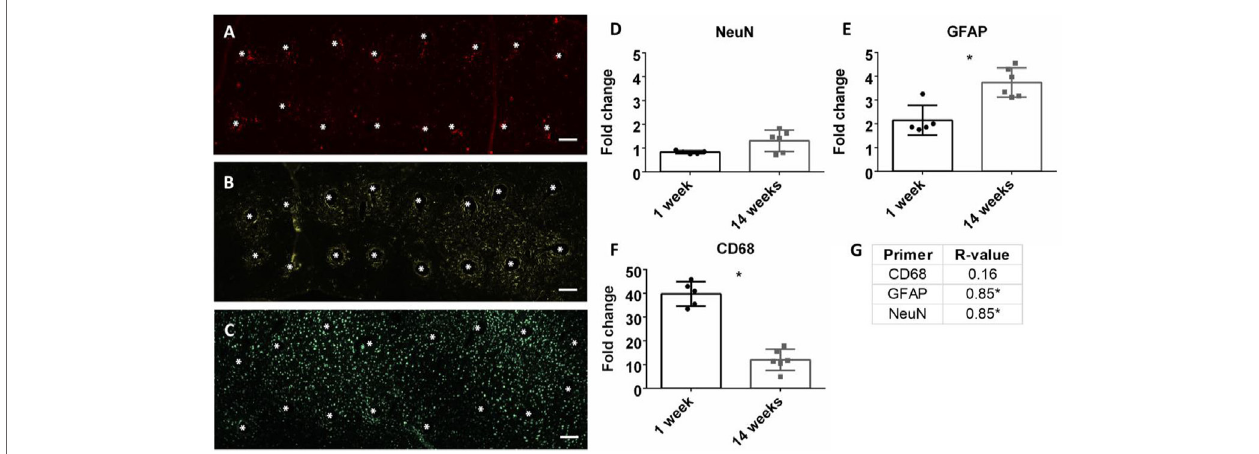
FigUre 3 | Representative images of 16 electrode microwire arrays at 1 week with * representing electrode location for (a) CD68, (b) GFAP, and (c) NeuN antibody staining (scale bar = 100 µm). Fold change comparison between 1 and 14 weeks for (D) NeuN, (e) GFAP, and (F) CD68 (* p < 0.05, Student’s t -test, Bonferroni corrected). Each time point was compared to age-matched naïve controls to calculate fold change. (g) Pearson correlation values for CD68, GFAP, and CD68 (* p <